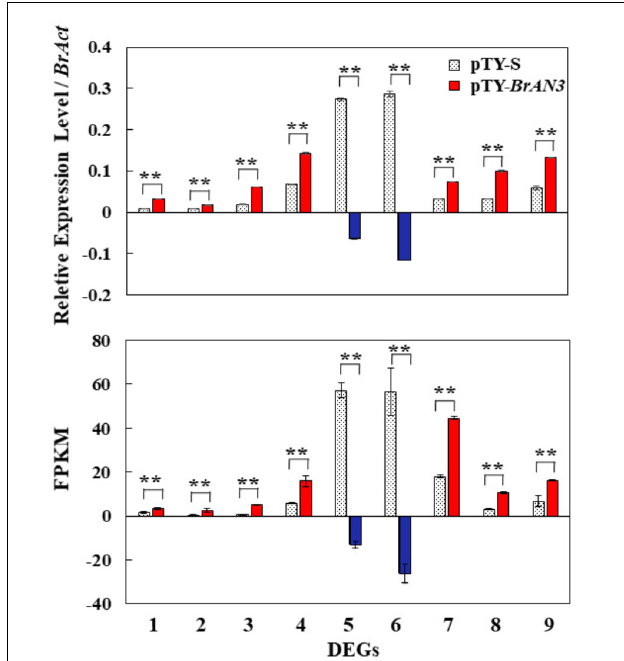
FIGURE 7 | Validation of the expression of 9 out of the 41 differential expression genes (DEGs) by real-time RT-PCR. Gene-specific primers were designed to target all the homologous sequences of each gene in Chinese cabbage. Relative expression levels were calculated using the standard curve method with BrAct ( Bra028615 ; Dheda et al., 2004) as the internal control gene. The FPKM expression levels were calculated as fragments per kilobase of exon model per million mapped (FPKM) values. Bars represent the means of three replicates ± standard errors (vertical bars). Genes: 1, Bra011332 ; 2, Bra014411 ; 3, Bra023958 ; 4, Bra027232 ; 5, Bra003044 ; 6, Bra022663 ; 7, Bra005136 ; 8, Bra017136 ; 9, Bra025708 . Asterisks indicate a significant difference between pTY-S- and pTY- BrAN3 -inoculated plants at p ≤ 0.01 as calculated by t -test.